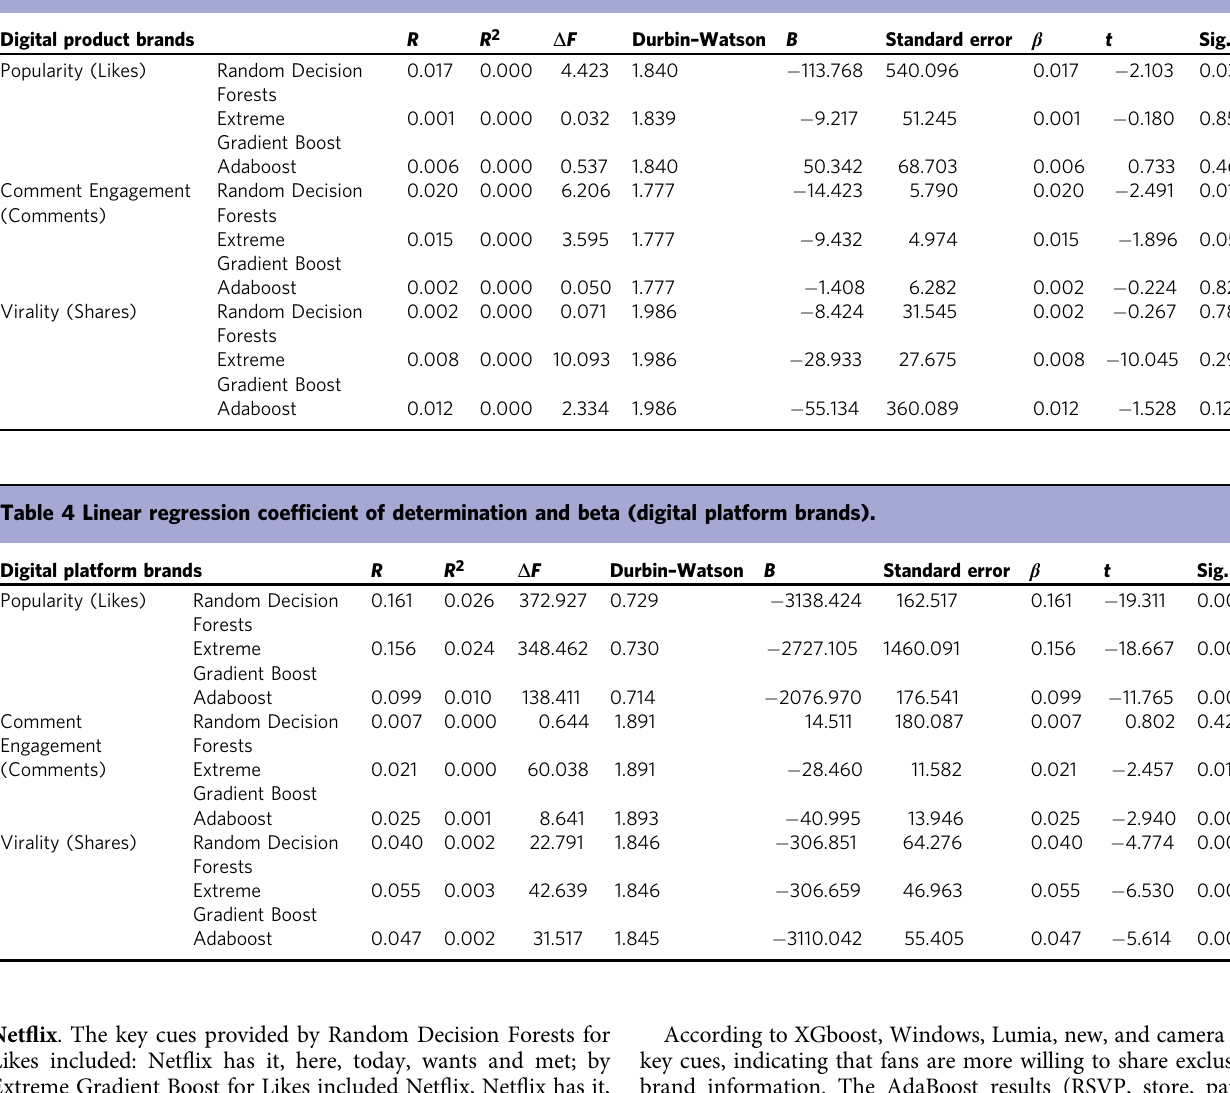
Table 3 Linear regression coef fi cient of determination and beta (digital product brands).